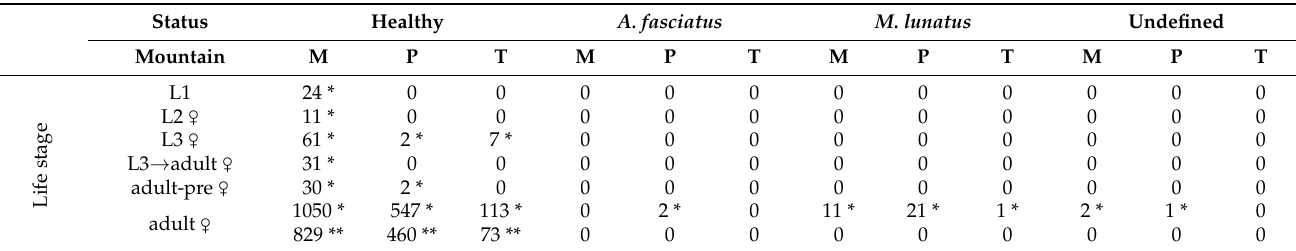
Table 6. Number of P. hellenicus female individuals with honeydew at a parasitized and non-parasitized (healthy) status in three sampled mountains of Greece during the whole sampling period